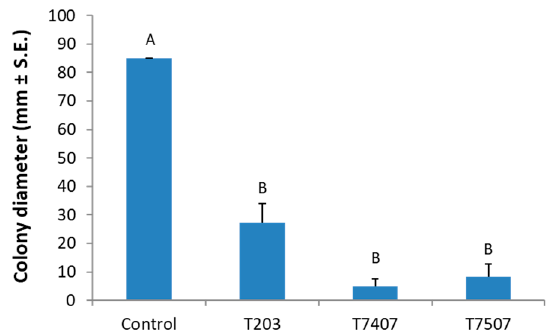
Figure 4. The Trichoderma spp. secreted metabolites effect on M. maydis solid media cultures. The Trichoderma isolates are T. asperelloides (T203) and T. longibrachiatum (T7407 and T7507). PDA dishes covered with cellophane membranes seeded with Trichoderma isolates for two days. After that, the cellophane with the Trichoderma colony was removed. The plate was then sown with M. maydis and incubated for 6 days. The control was regular PDA medium M. maydis cultures maintained at the same conditions. Values are the means from three biological replicates ± standard error. Different letters (A,B) indicate significant differences (one-way ANOVA test, p < 0.05).